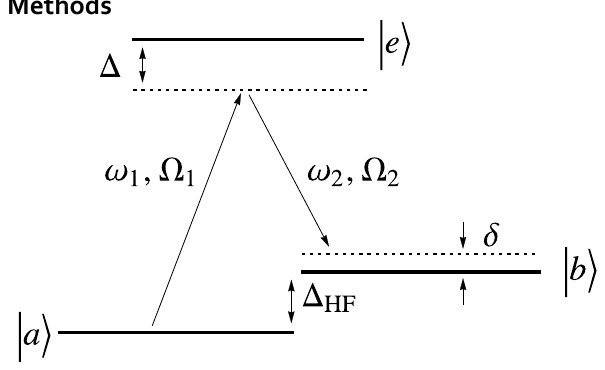
Figure 6. Raman coupling in a Λ system: three hyperfine levels of 87 Rb are coupled by two laser fields with frequency ω 1 , ω 2 and Rabi frequency Ω 1 and Ω 2 . Here Δ represents the common detuning with the state | e 〉 , while Δ HF is the energy difference between the hyperfine levels | a 〉 e | b 〉